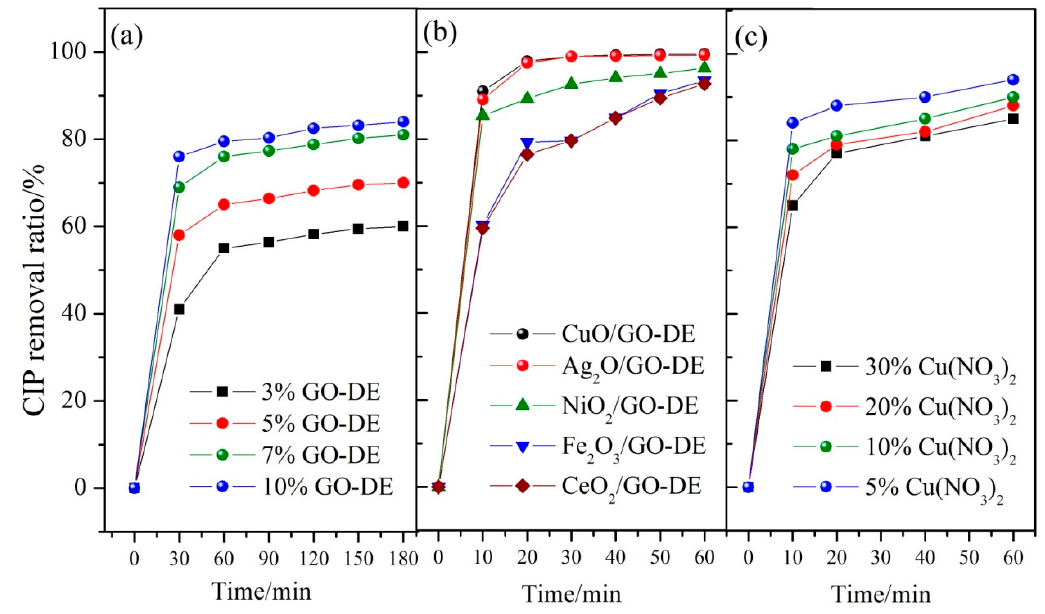
Figure 1. ( a ) Influence of proportions of GO integrated with DE on CIP removal ratio; ( b ) influence of metal type loaded on GO-DE on CIP removal ratio; ( c ) influence of precursor concentration on CIP removal ratio.